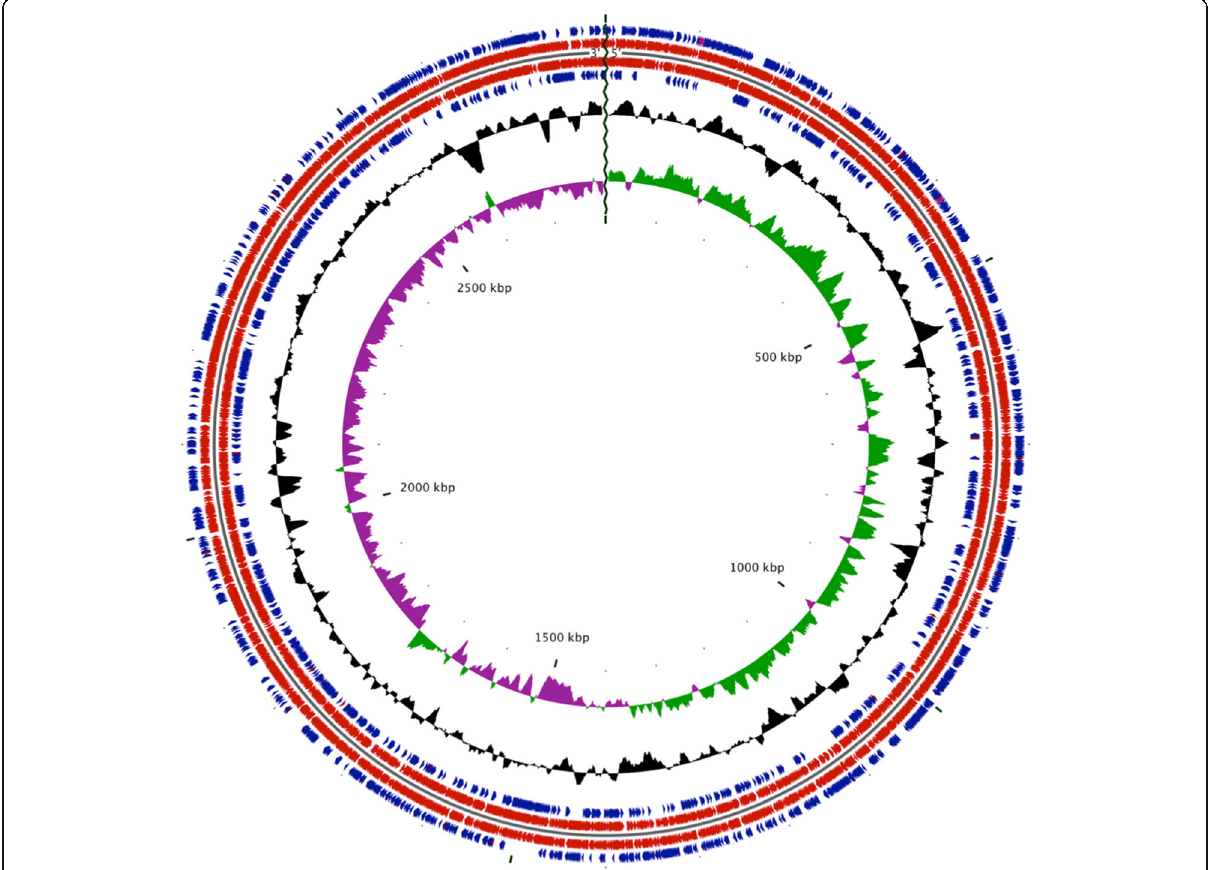
Fig. 2 Circular representation of the high quality draft genome of A. albertensis T displaying relevant genome features. The features are the following (from outside to inside): Genes on forward strand (red); Genes on reverse strand (red); CDSs (blue), GC content (black); GC skew (green and